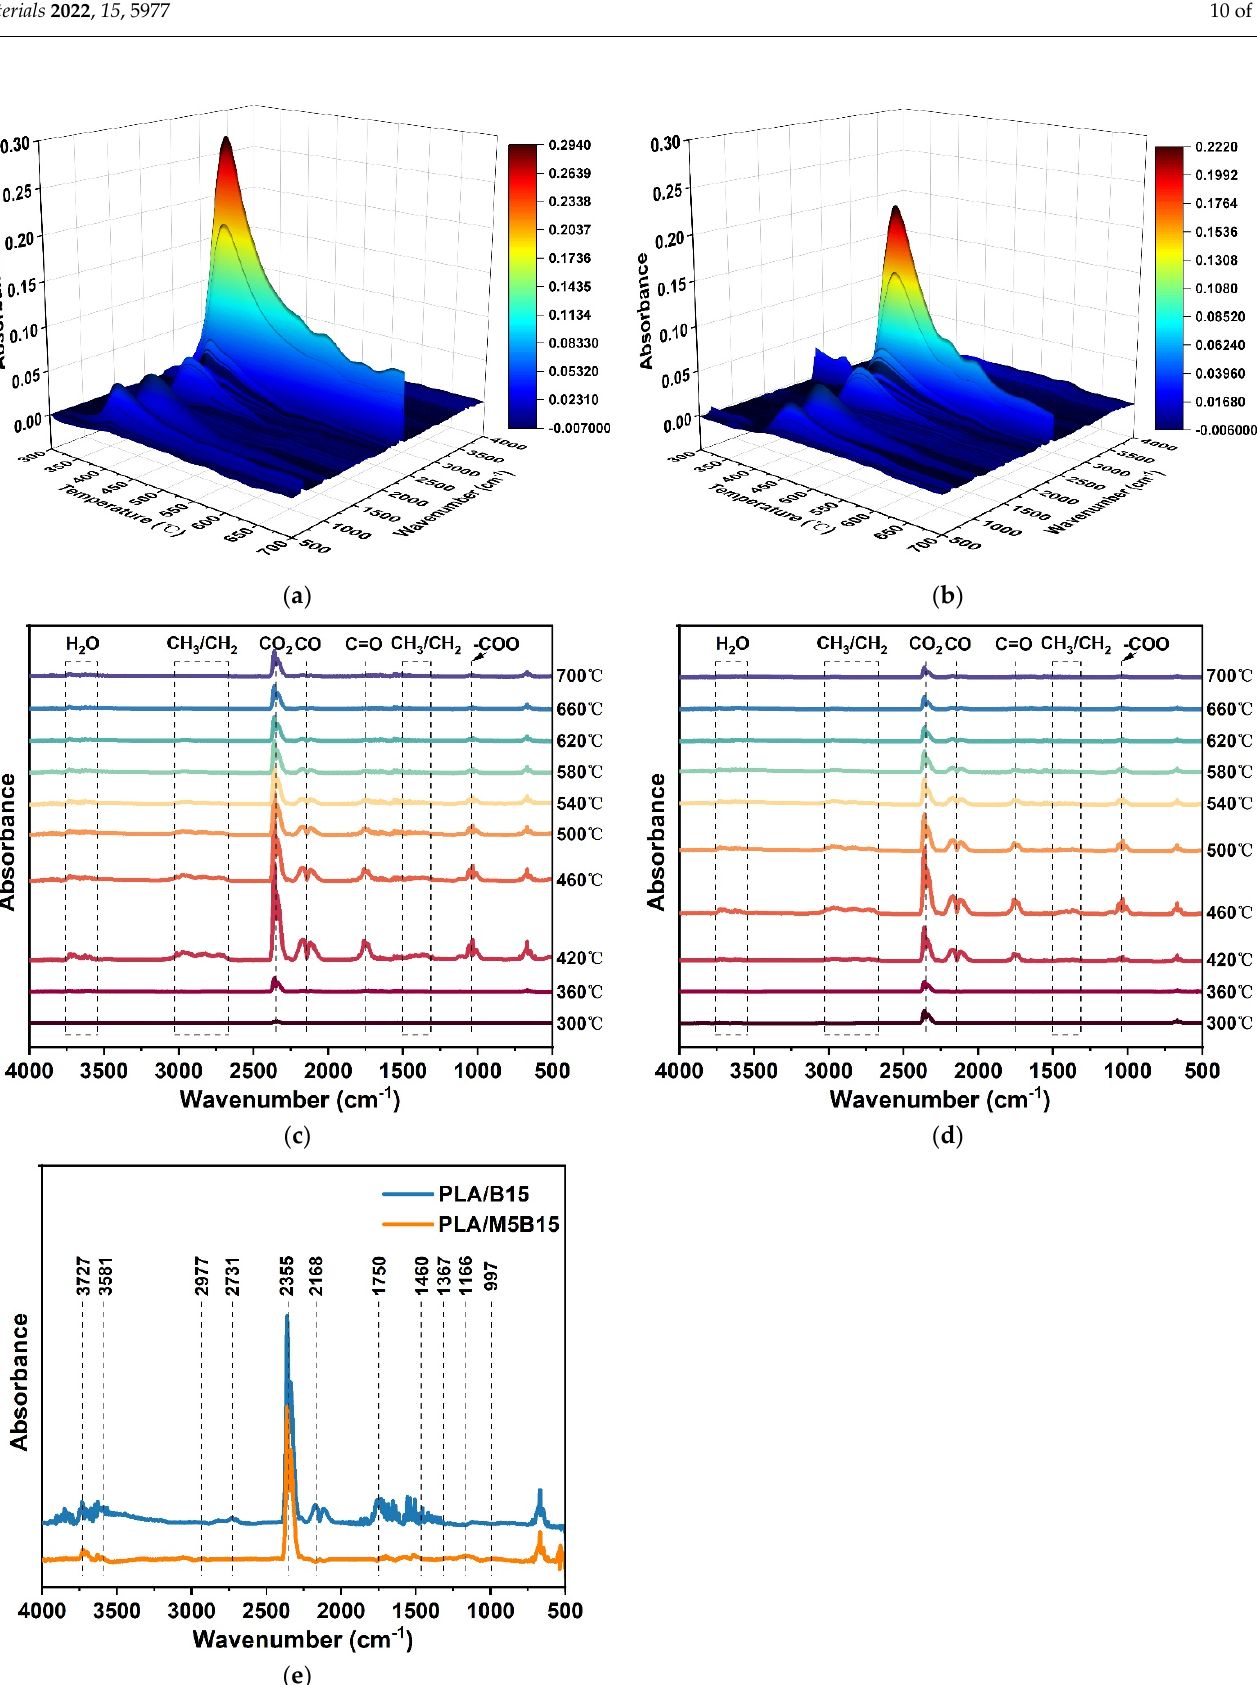
Figure 7. 3D thermogravimetric analysis-infrared spectrometry (TG-IR) spectra of ( a ) PLA/B15 and ( b ) PLA/M5B15 under air atmosphere. IR spectra of PLA/B15 and PLA/M5B15 at ( c , d ) various temperatures and ( e ) 360 °C.